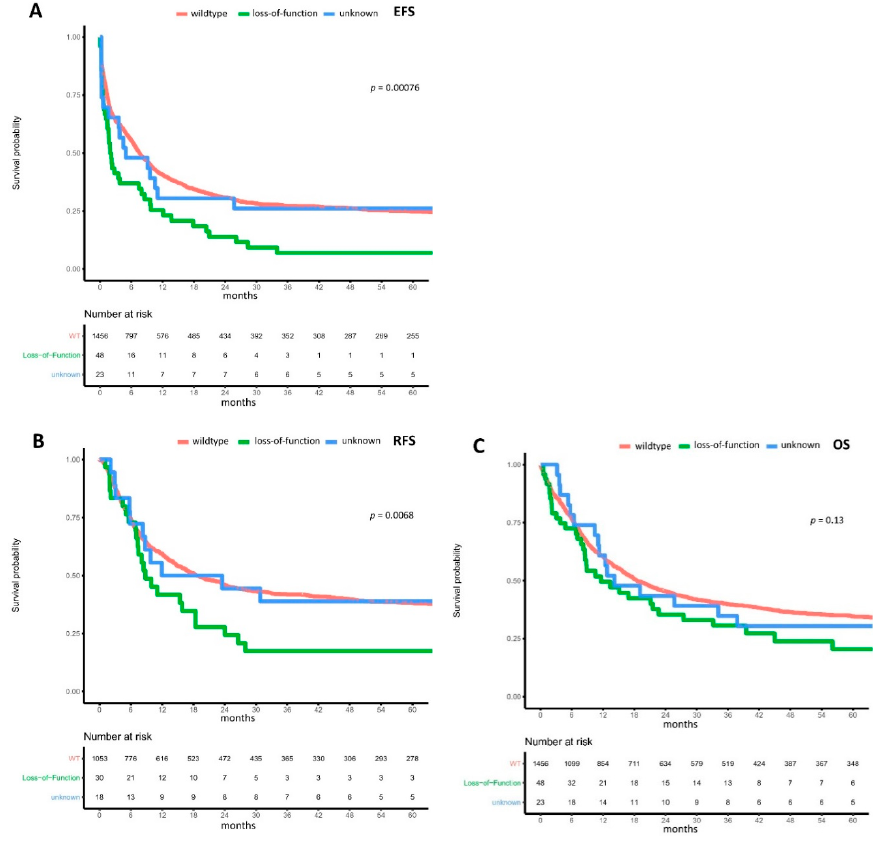
Figure 4. Impact of BCOR loss-of-function mutations on outcomes. Kaplan–Meier plots for ( A ) event-free survival, ( B ) relapse-free survival, and ( C ) overall survival in AML, with mutations of BCOR resulting in a transcriptional stop and loss-of-function (green), BCOR mutations without transcriptional stop resulting in unknown function (blue), and wild-type BCOR (orange) compared using the logrank test.